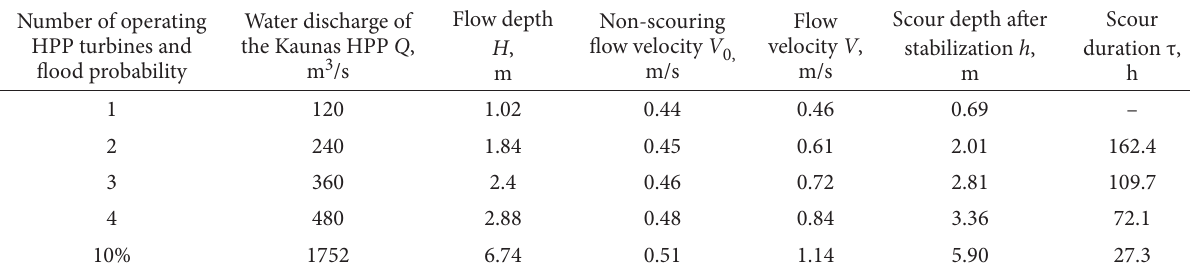
Table 2. Estimation results of the maximum depth and duration of bridge abutment scour ( d = 0.2 mm) Number of operating HPP turbines and